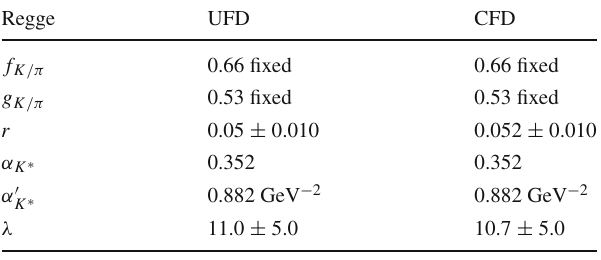
Table 7 Values of Regge parameters involving strangeness. They are all allowed to vary from our UFD to our CFD sets with the exception of α K ∗ and α (cid:5) , since they are both determined from linear Regge K ∗ trajectory fits to strange